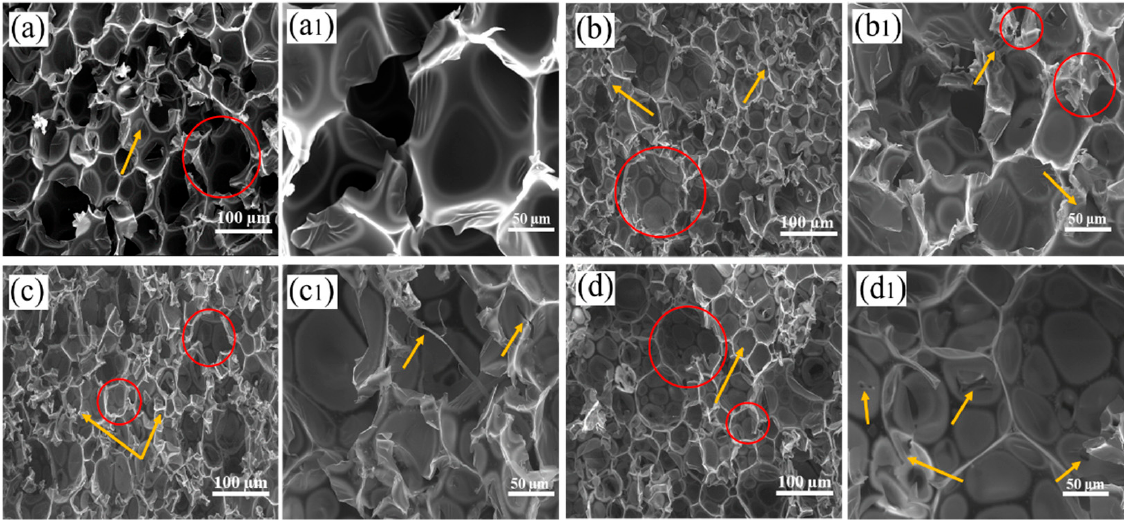
Figure 1. SEM images of RPUF and RPUF-R composites: ( a , a1 ) RPUF; ( b , b1 ) RPUF-1; ( c , c1 ) RPUF-3; ( d , d1 ) RPUF-5.